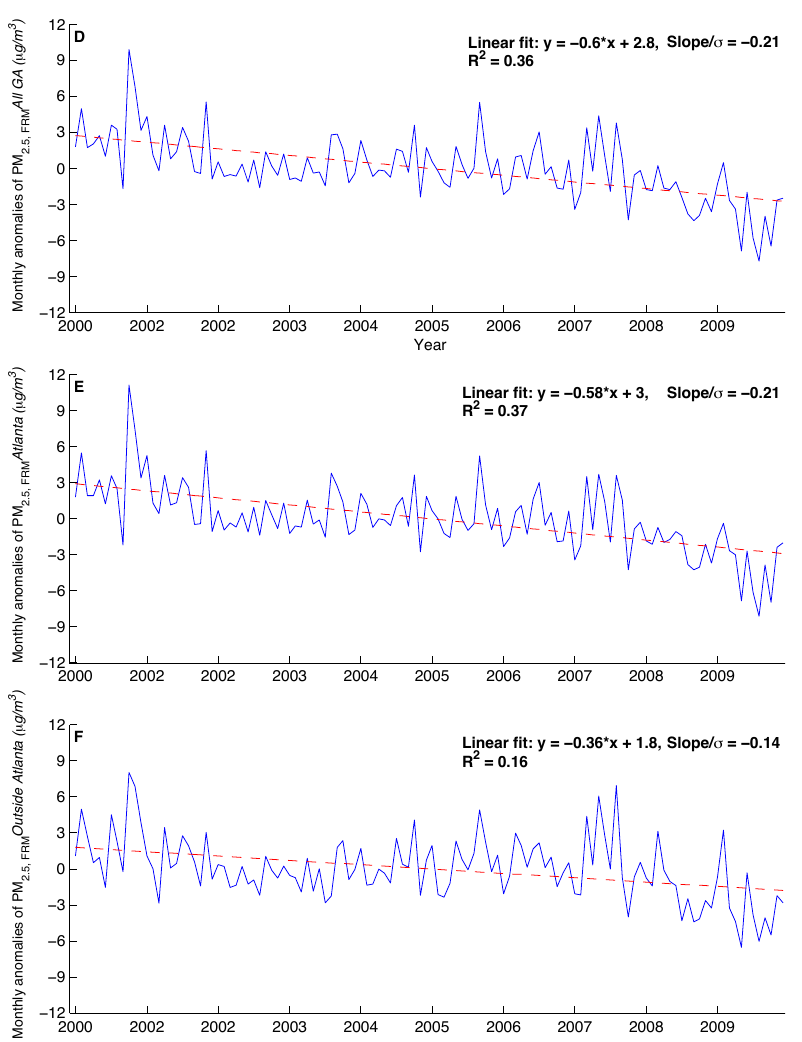
Fig. 9b. (D–F) Time series of monthly anomalies for PM 2 . 5 , FRM AllGA , PM 2 . 5 , FRM Atlanta and PM 2 . 5 , FRM OutsideAtlanta . The units for all PM 2 . 5 are µgm − 3 . Dashed red lines denote linear regression trend lines (see Table 1). Linear regression equations, linear fit statistics and normalized slopes=slope/standard deviation ( σ ) are